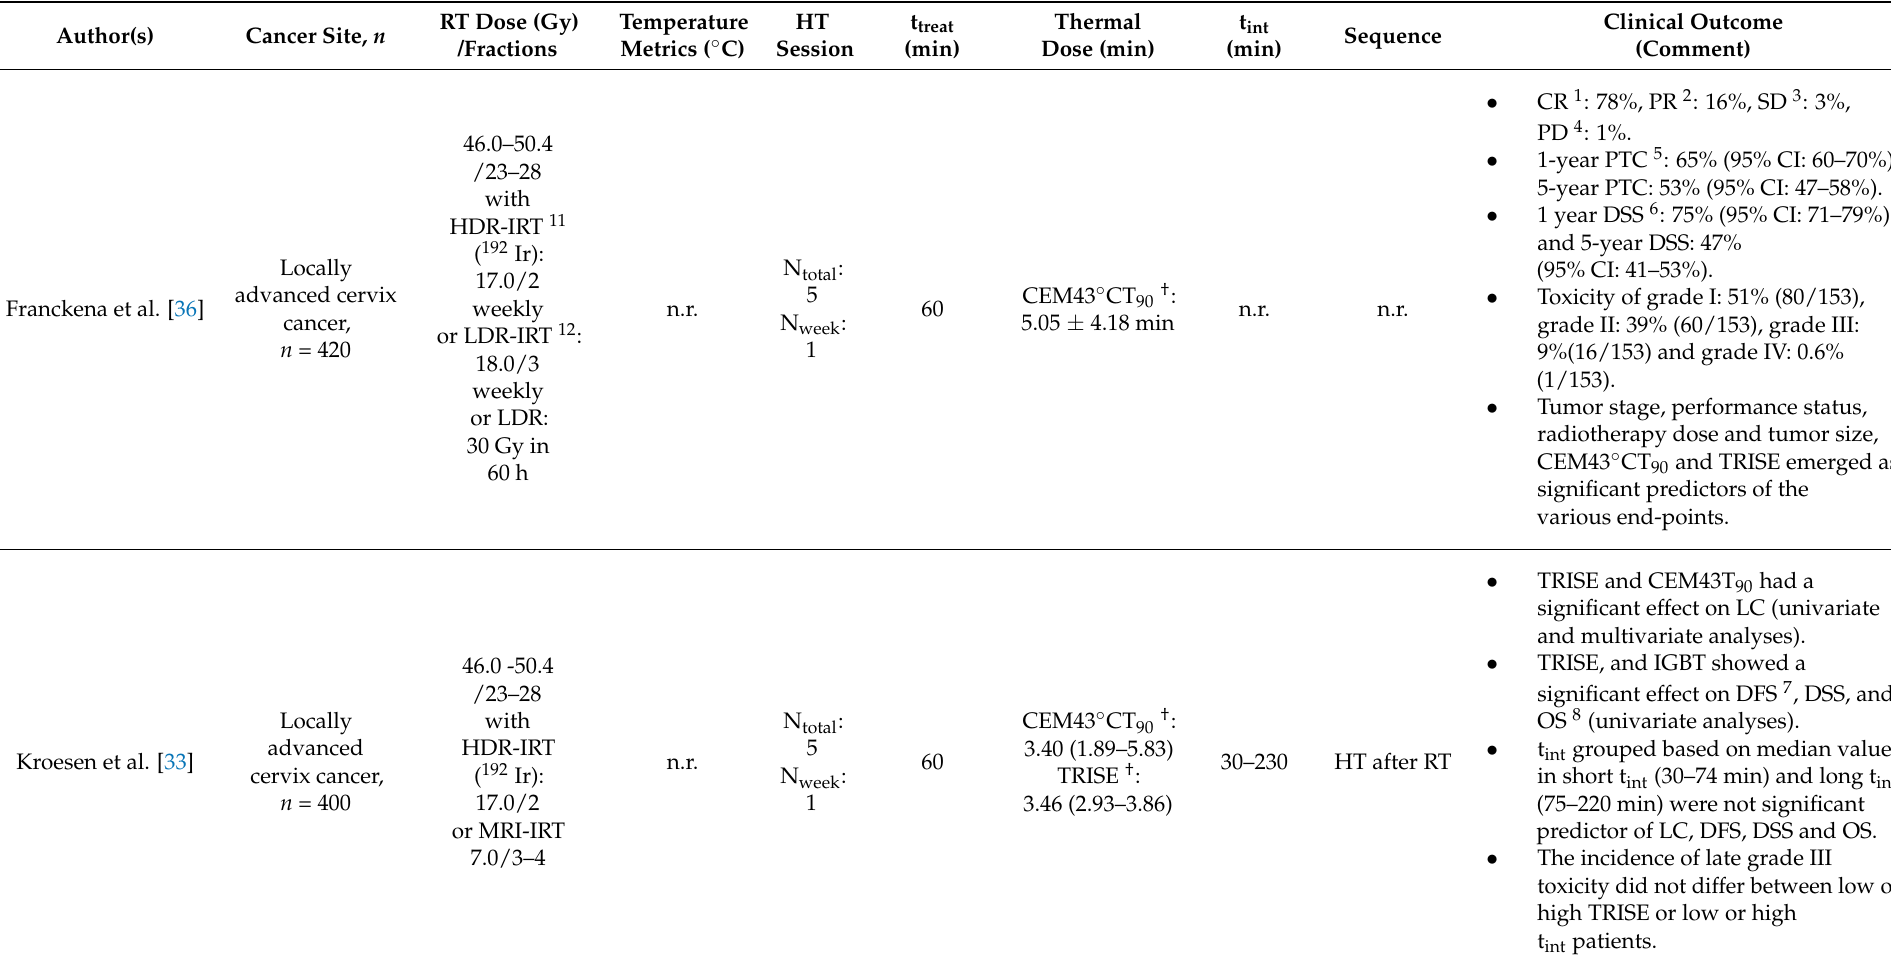
Table 8. Retrospective clinical studies using RT in combination with